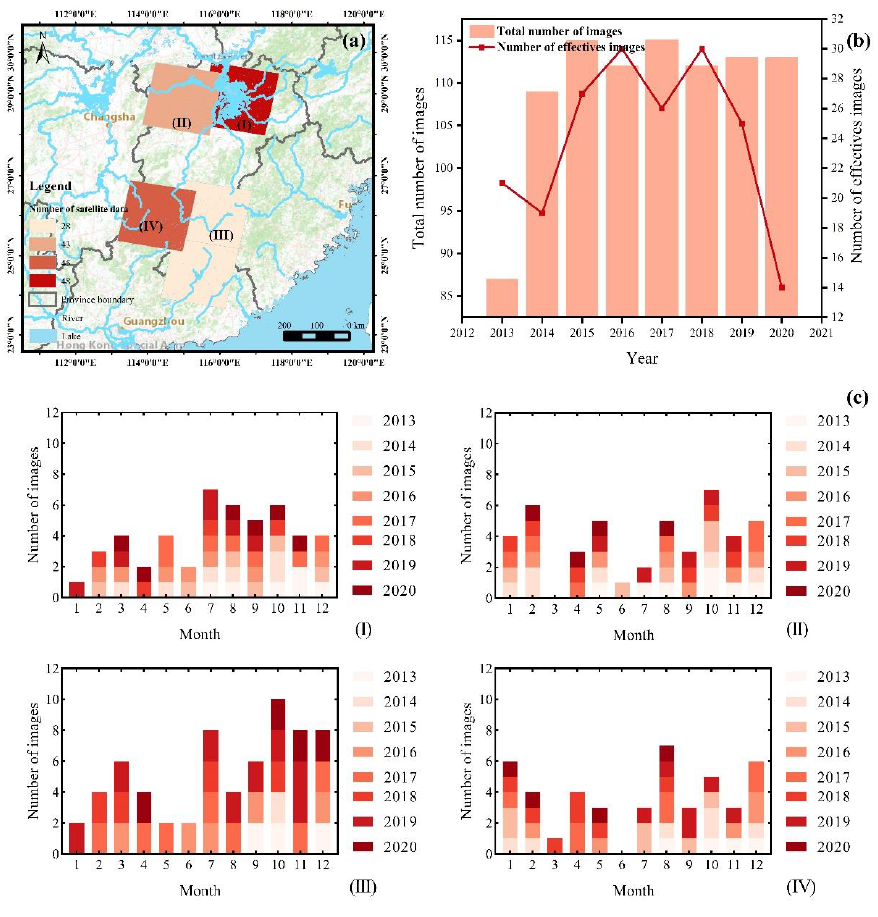
Figure 2. Statistics of Landsat imagery across PLB from 2013 to 2020. ( a ) Spatial distribution of the total Landsat-8 images across the PLB from 2013 to 2020 coverage; ( b ) the annual number of available Landsat images; ( c ) the monthly number of available Landsat images across PLB (( I ) Poyang Lake region; ( II ) Zhelin Reservoir region; ( III ) Tao River region; ( IV ) Yangming Lake